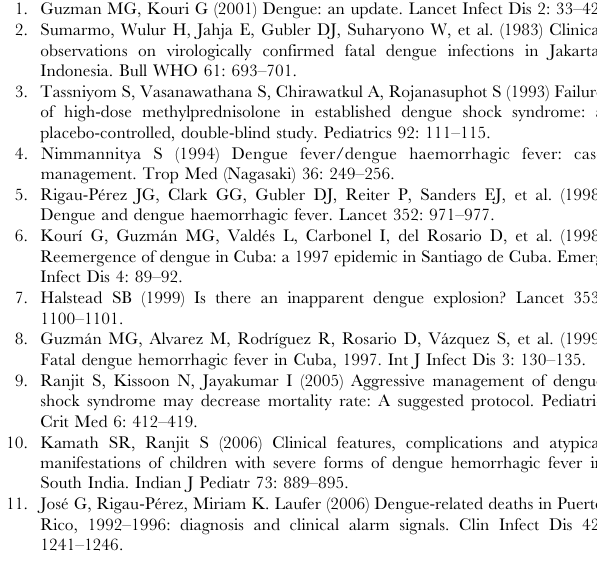
Table S1 Demographic, clinical and laboratory information of the 10 fatal patients with dengue hemorrhagic